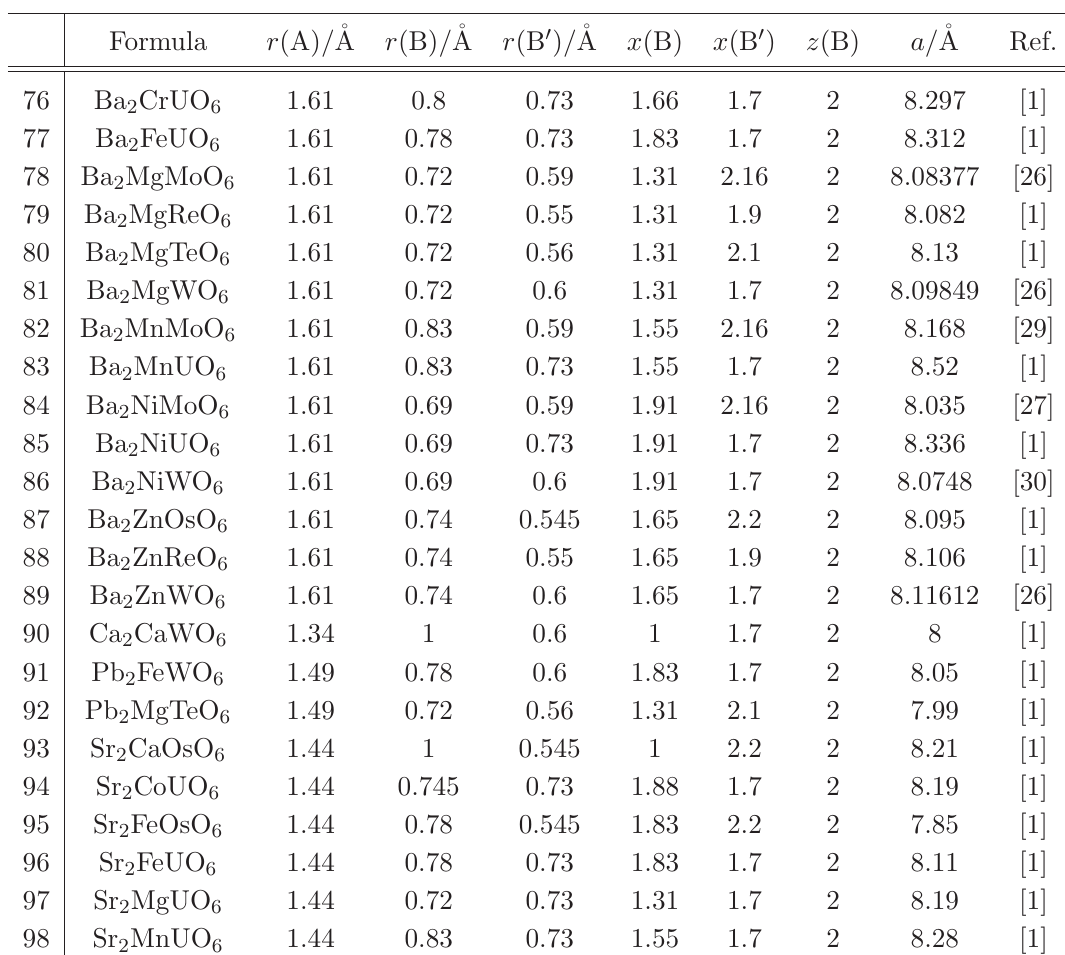
Table 1 (continue) Input data in the analysis: radii of the constituents ( r ), electronegativity of the B-cations ( x ), the oxidation state of B-cation ( z ) and lattice parameter ( a